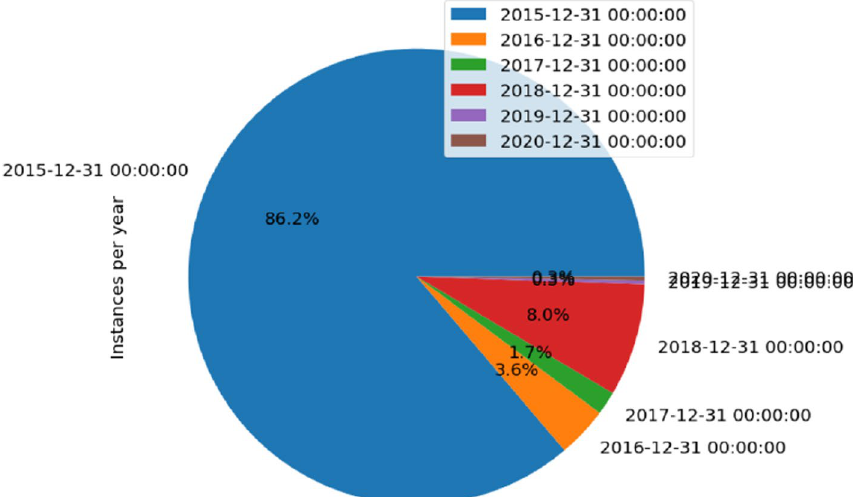
Fig. 11 Yearly distribution of electricity load profiles in cluster 2 (363 samples from the 2015–2022 dataset)